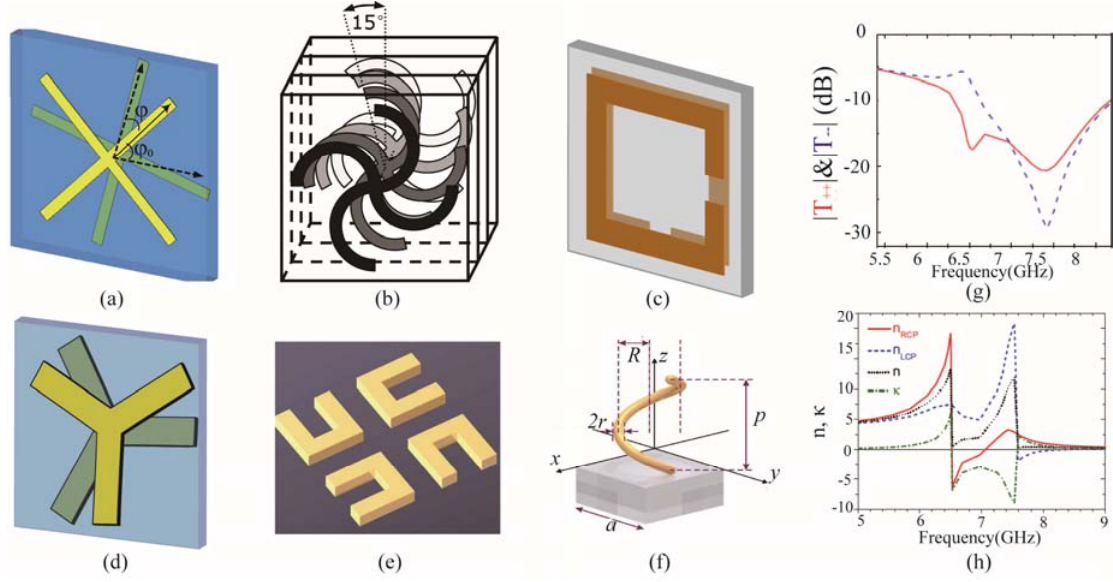
Figure 1. Typical unit cells of chiral metamaterials. ( a ) Twisted cross structure [74]; ( b ) Twisted gammadion structure; ( c ) Twisted split ring structure; ( d ) Twisted Y-shape structure; ( e ) Twisted U-shape structure; ( f ) Helix structure; ( g )The circular transmission for the chiral metamaterial in ( a ); ( h ) The retrieved effective refractive index and chirality for the chiral metamaterial in ( a ). ( a , g , h ) are reproduced with permission from [74]. Copyright American Physical Society, 2009; ( b ) is reproduced with permission from [75]. Copyright American Physical Society, 2009; ( e ) is reproduced with permission from [77]; and ( f ) is reproduced with permission from [55].